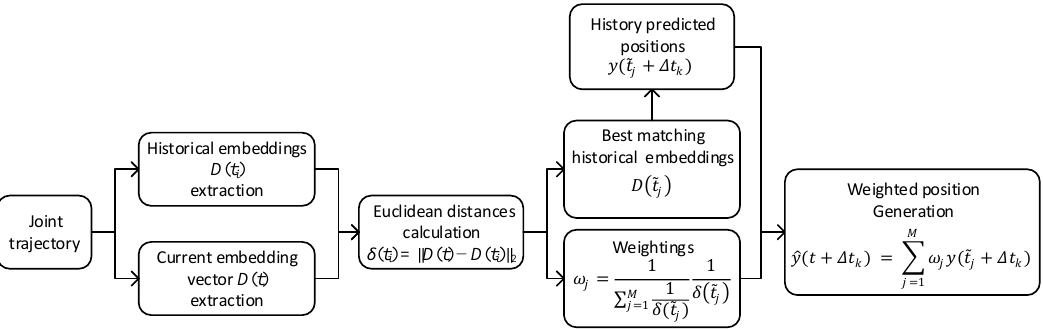
Figure 2. Takens’ basic reconstruction method